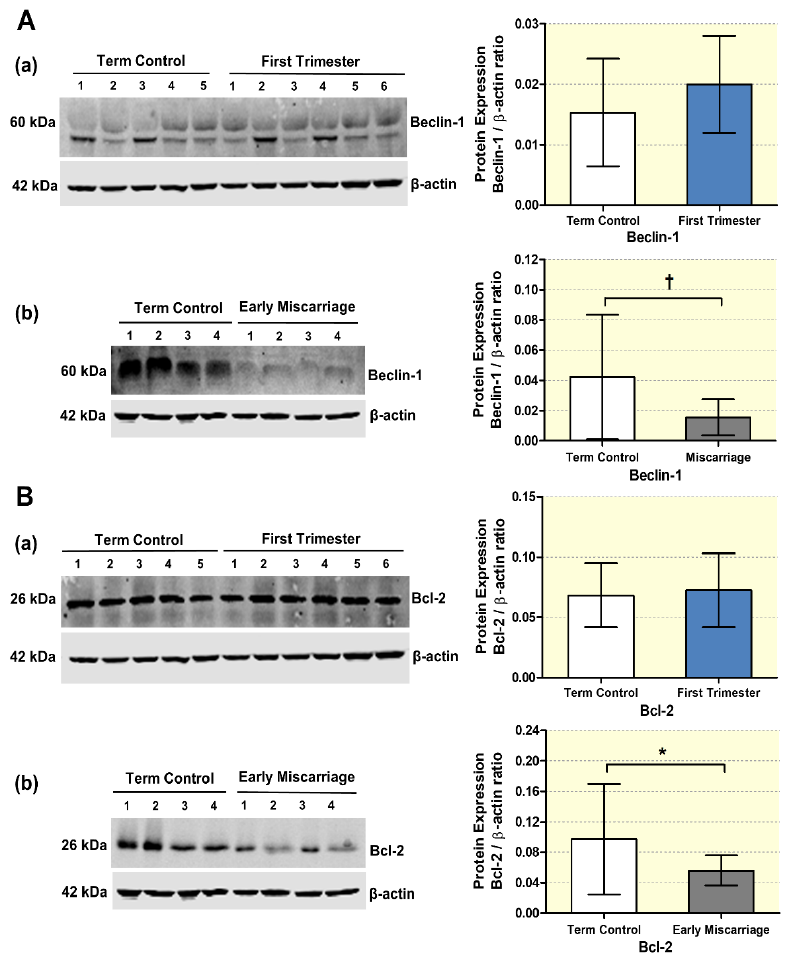
Figure 3. Protein expression changes in autophagy regulatory proteins in placental tissues . ( A ) Beclin-1, ( B ) Bcl-2 expression visualized by immunoblotting in placentae from ( a ) first trimester and term controls ( n = 6 and n = 5, respectively; Swiss cohort), ( b ) EMC patients and term controls ( n = 20